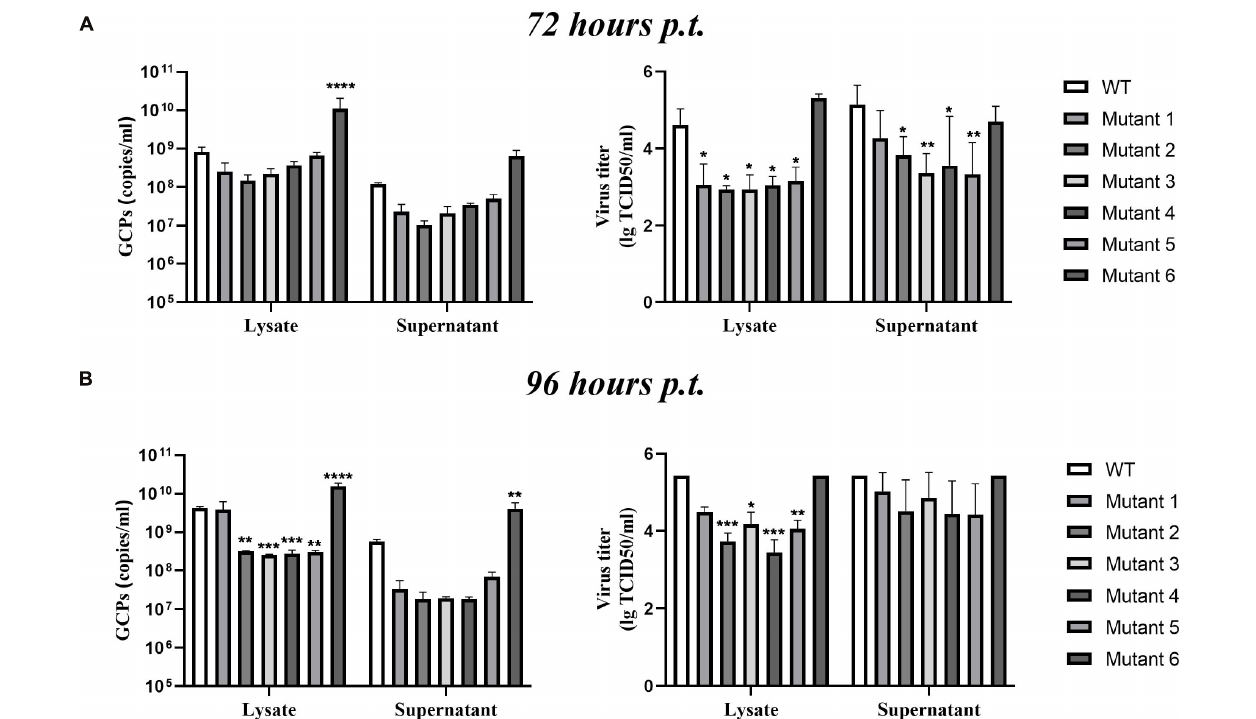
FIGURE 3 | Infectious virus production in BHK-21 cells. The viral titer and genome-containing particle (GCP) level of the cell lysate and supernatants collected at 72 h post-transfection (p.t.) (A) and 96 h p.t. (B) were quantified by TCID 50 and qPCR. Means and standard errors are from three independent experiments. * p ≤ 0.05; ** p ≤ 0.005; *** p ≤ 0.001; **** p ≤